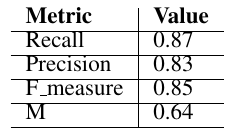
Table 1. Quantitative results of the spatiotemporal